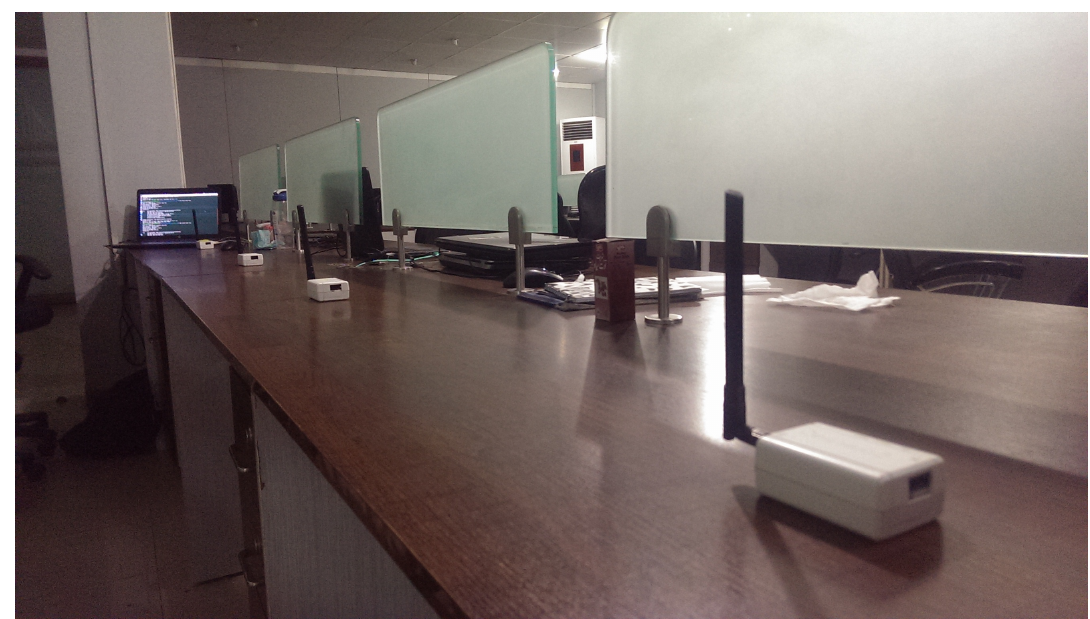
Figure 8. Indoor experimental setup with real Z1 motes to evaluate the proposed approach for IoT sensing